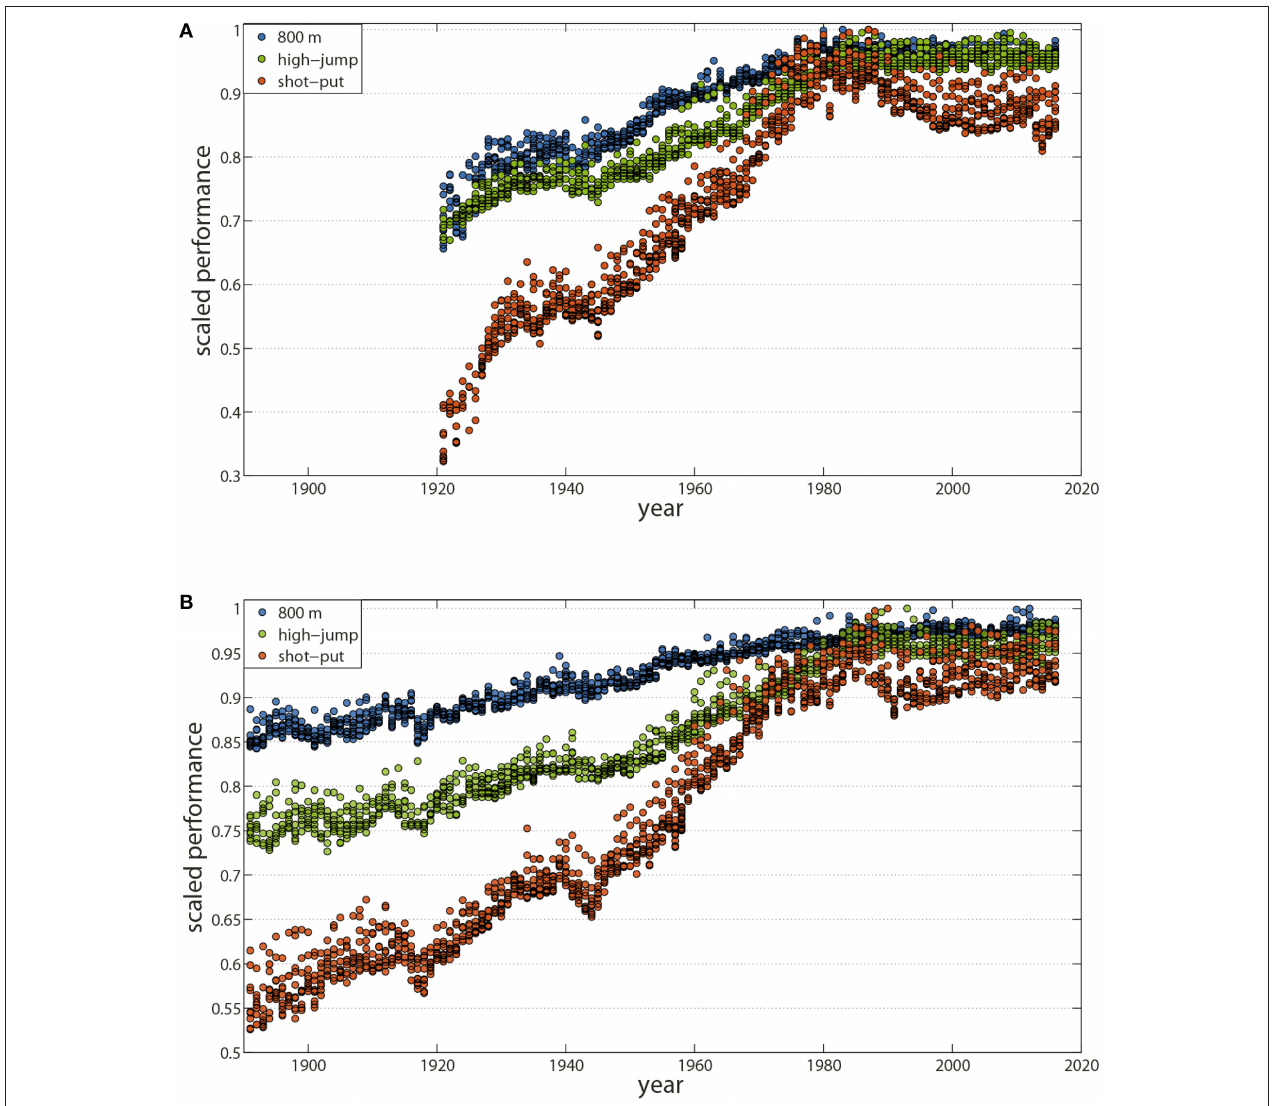
FIGURE 1 | Maximal physical performance has plateaued during the last three decades . Historical series of the best performances in Track and Field events have shown trends of plateauing since 1980 for both men and women, one of the early signs of established human physiological limits. (A) Annual World’s 10 best performances from 1921 to 2016 in women for the 800m event (blue), the high-jump event (green), and the shot-put (orange). (B) Annual World’s 10 best performances from 1896 to 2016 in men for the 800m event (blue), the high-jump event (green), and the shot-put (orange). Data are from International Association of Athletics Federations (IAAF: https://www.iaaf.org/home) and are normalized by the respective world records for the event at the end of 2016, that is, performances are divided by the current world